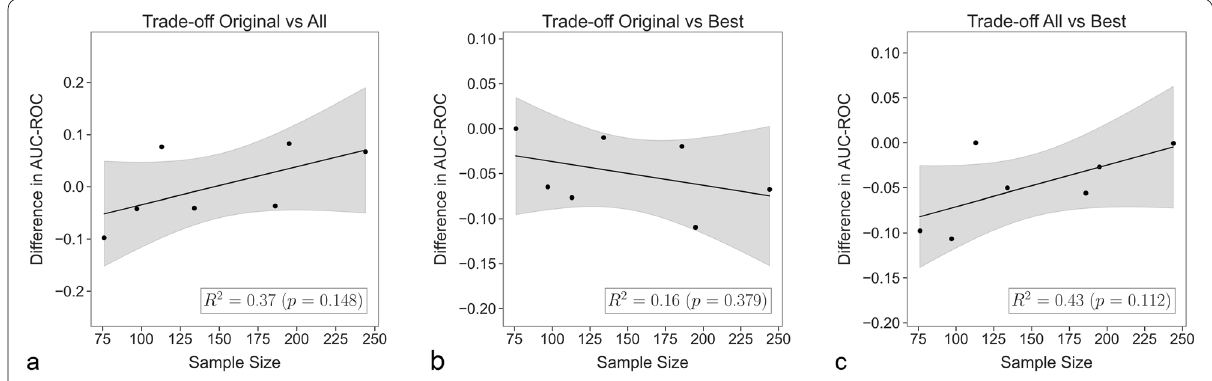
Fig. 3 Tradeoffs against sample size. Graphical display of the association of the difference in area-under-the-curve at receiver operating characteristics between the three feature sets and the sample size. Each point corresponds to one of the datasets. a Tradeoff between the original set and all features. b Tradeoff between the original set the best-performing feature set. c Tradeoff of all features and the best-performing feature set